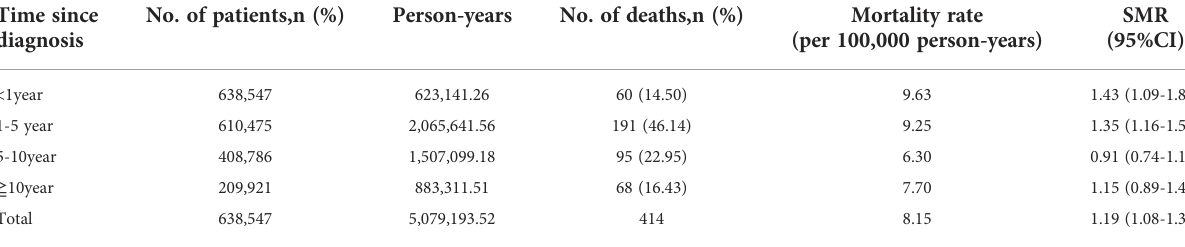
TABLE 3 Suicide rates, according to time since diagnosis, female breast cancer survivors, 2000 to 2017. Time since